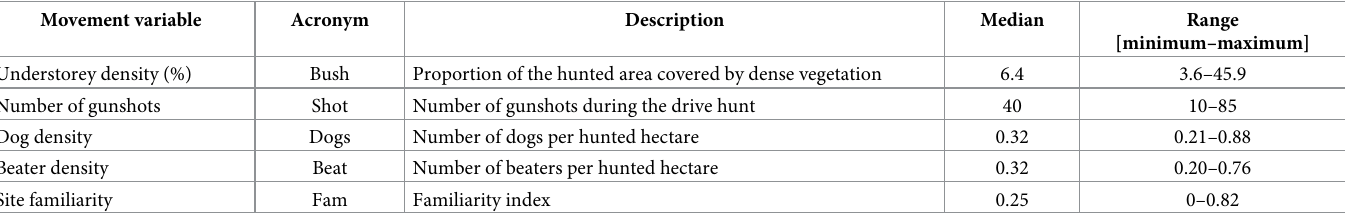
Table 1. Median values and range of the five movement variables used in the model described in Eq 2 and calculated to investigate the determinants of immediate movement responses of red deer in the National Estate of Chambord, France, 2016–2018. Median values and ranges were calculated for all the hunting events (n =